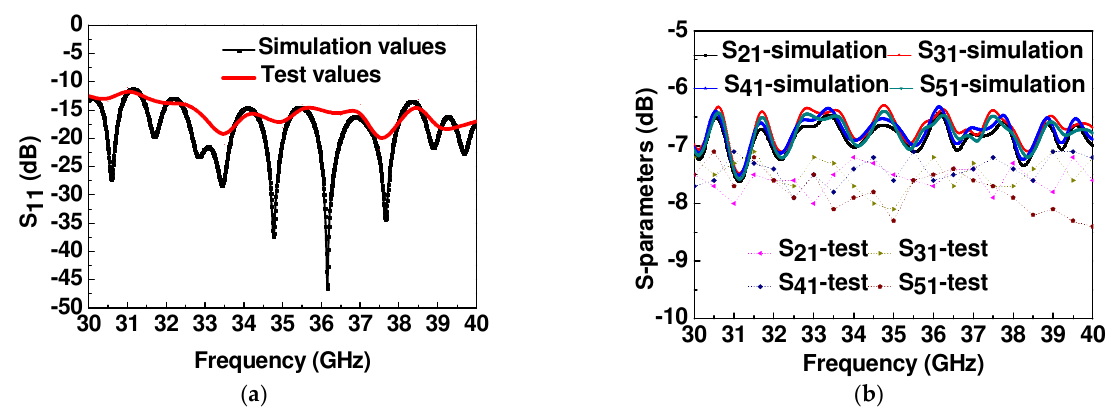
Figure 11. Comparison between simulation values and test values for S 11 parameters ( a ); transmission losses ( b ).